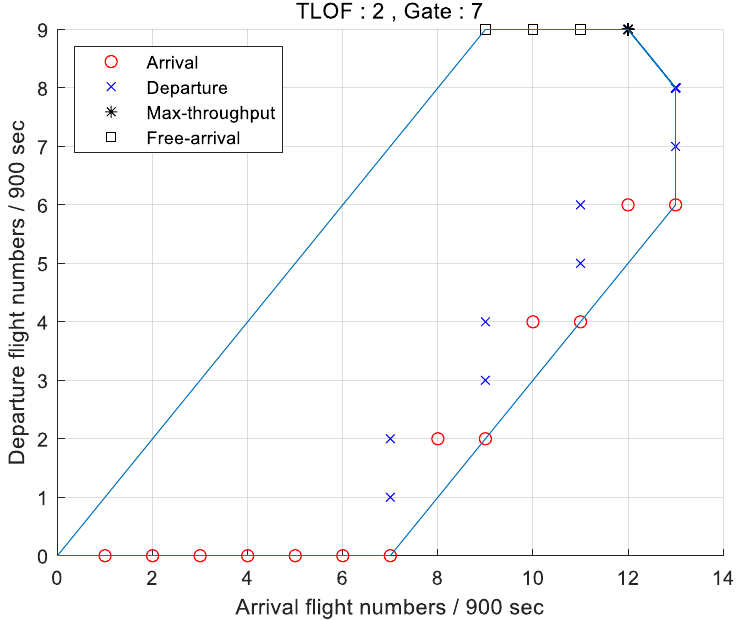
Figure 37. Capacity of a satellite topology for the expanded Gimpo Airport parking lot that complies with the EASA’s new regulations.